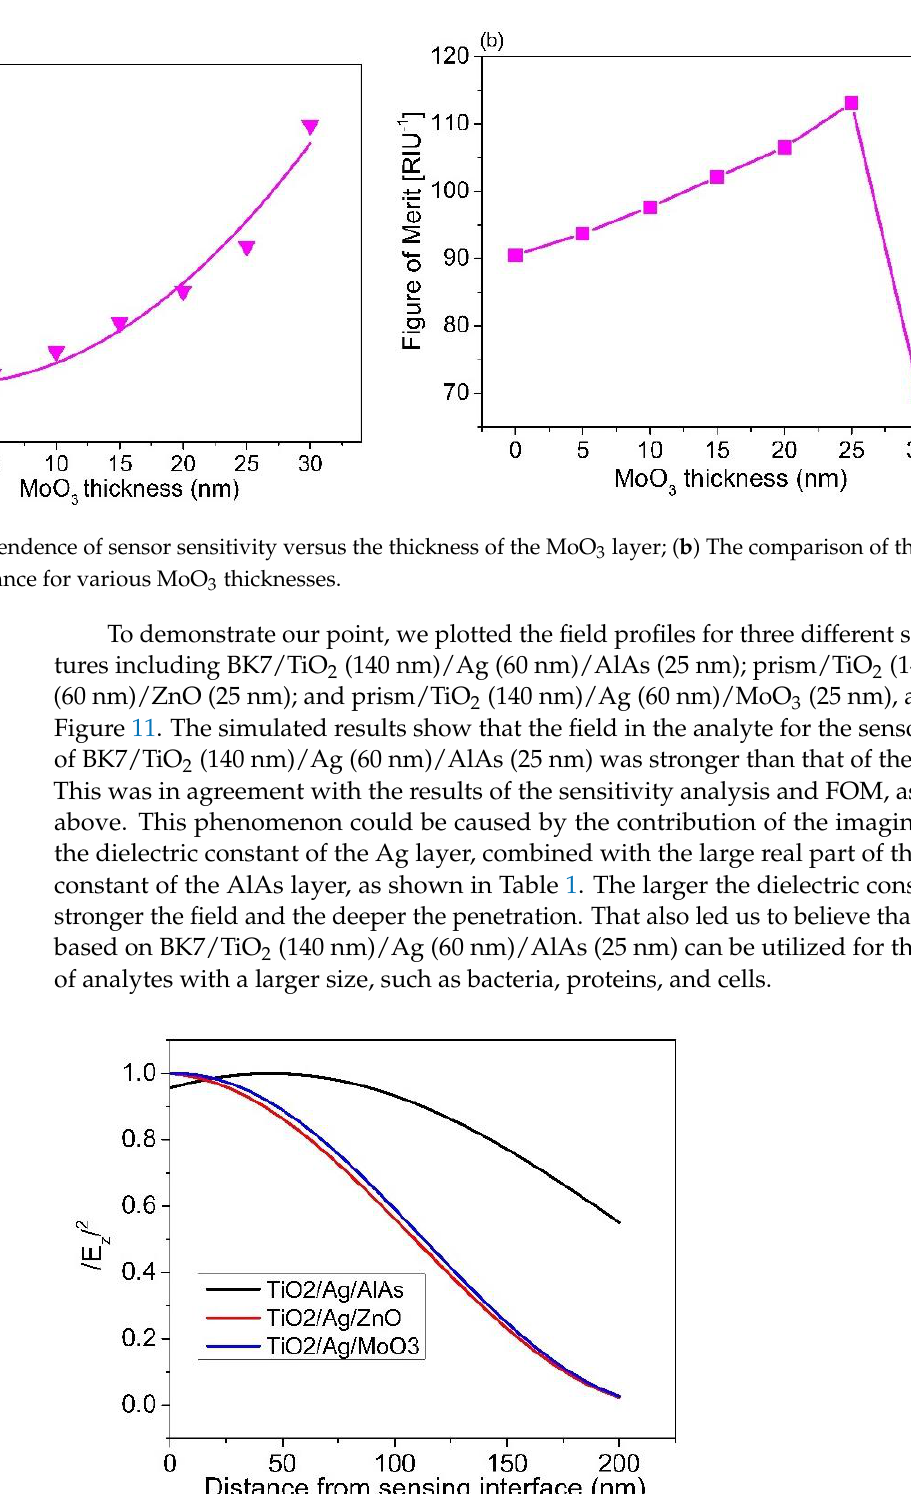
Figure 9. SPR spectra for varying thicknesses of MoO 3 based on the sensor structure of the BK7/TiO 2 /Ag/MoO 3 /sensing medium; ( b ) magnified view of ( a ); ( c ) the relationship between energy transfer and the MoO 3 thickness; ( d ) the change in resonance for different RI of the sensing medium based on the sensor structure of BK7/TiO 2 (140 nm)/Ag (60 nm)/MoO 3 (25 nm).